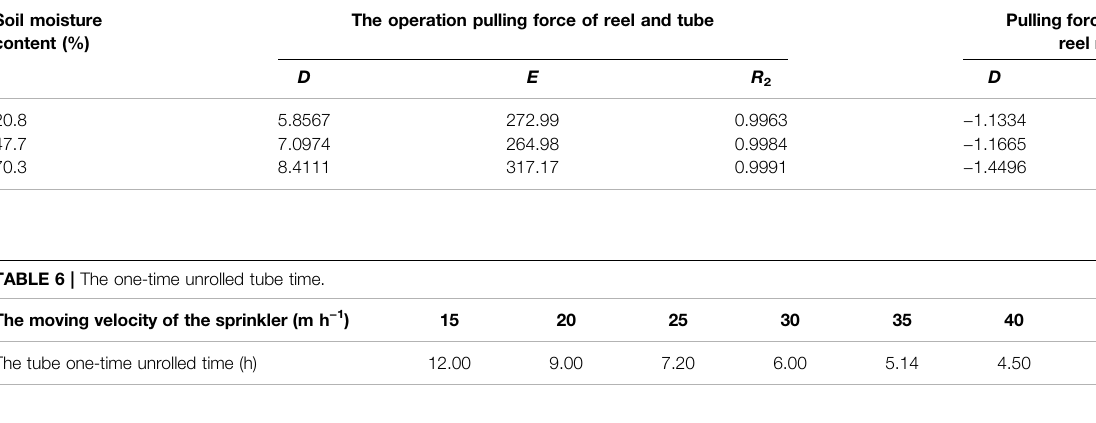
TABLE 5 | Coef fi cient of the fi tting equation for the reel and the